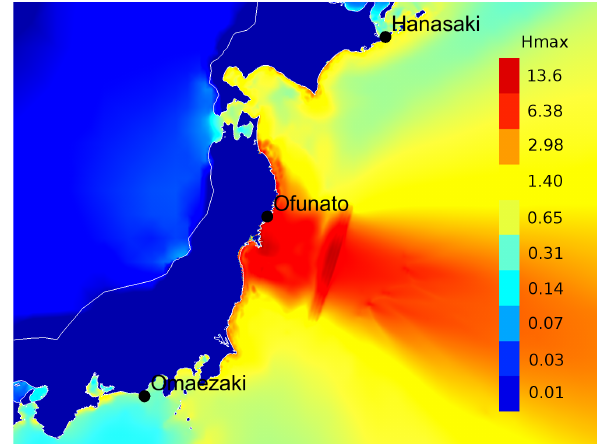
Fig. 8. Evolution with physical time of the total number of grid points.